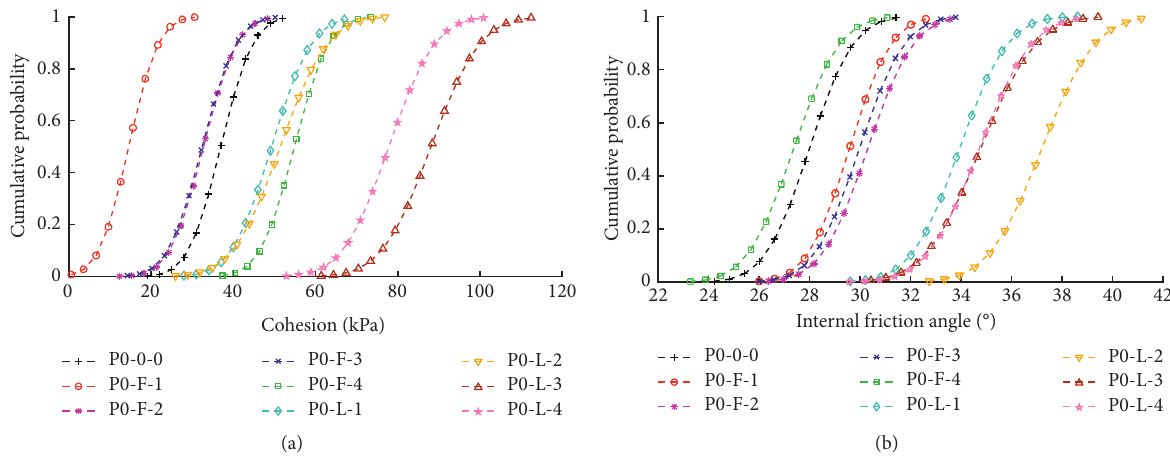
Figure 6: Cumulative probability distribution of the c and φ of the modified iron tailings with the one freeze and thaw cycle. (a) A cumulative distribution image of the cohesion c and (b) a cumulative distribution image of the internal friction angle φ .